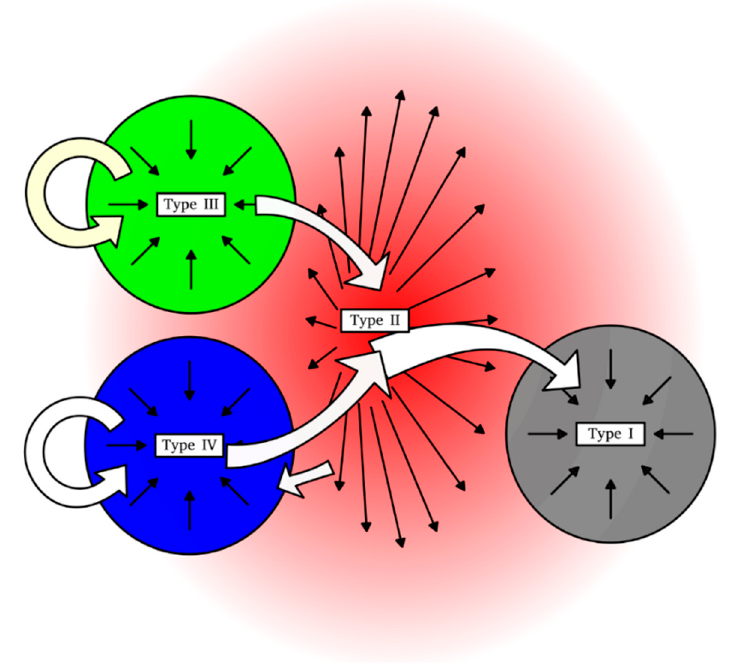
Figure 12. Conceptualization of ecological equilibria at Reserva Los Cedros. Arrows indicate the direction of change between basins that were hypothesized as possible from our observations. Type